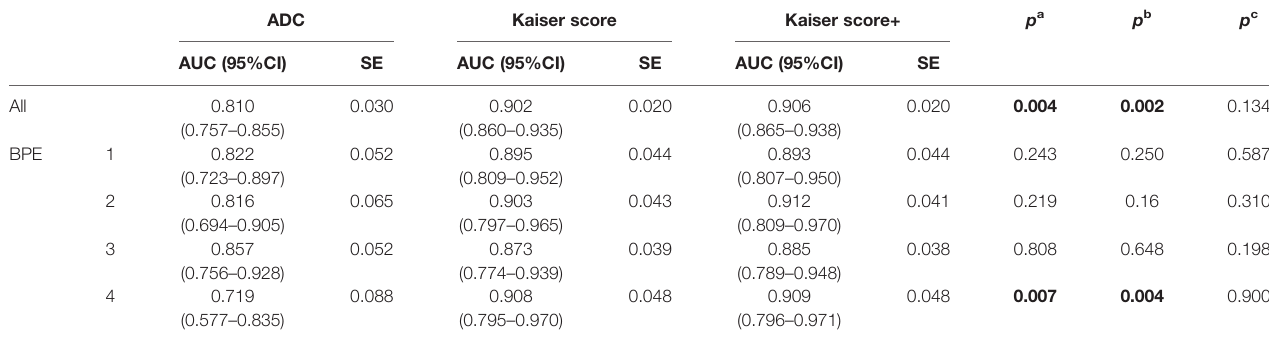
TABLE 4 | Comparison of ROC curves of Kaiser score, Kaiser score+, and